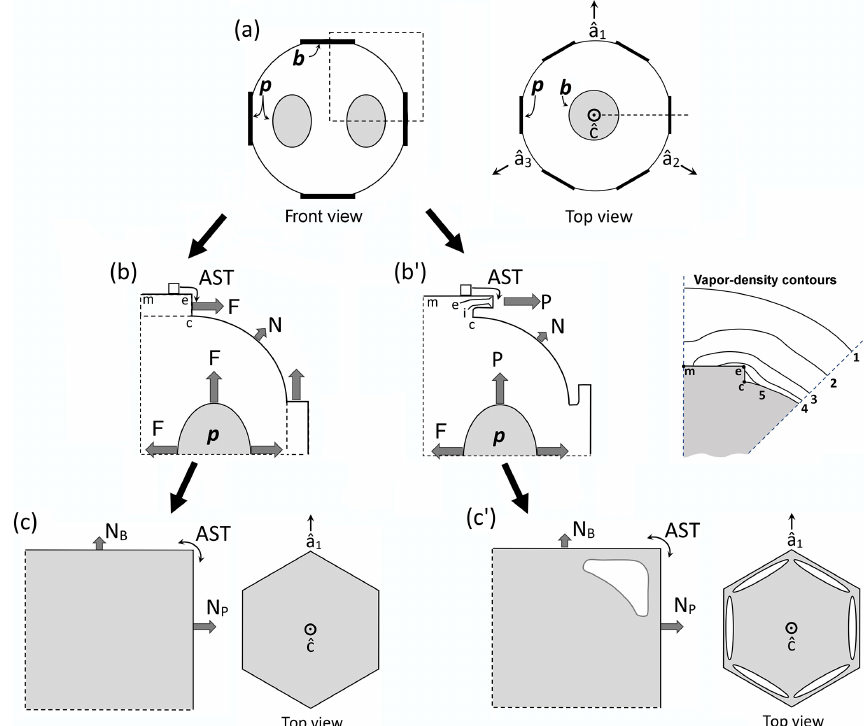
Figure 2. Concepts of lateral facet growth (types F , P , S ) for the droxtal-to-prism transition, driven by AST. (a) Droxtal with small basal b and prism p faces. Front view on the left shows four prism and both basal faces. The top view on the right shows all six prisms and the crystallographic directions of the c axis ˆ c and the a axes ˆ a . (b) Upper-right quadrant of (a) in dashed box, front view. Facet spreading F on top basal and two prism faces largely driven by adjoining surface transport (AST). Normal growth N occurs on rough regions between faces (continuous growth); m is the middle of the facet. (c) Filled-out basal and prism faces. AST continues, likely with net amount to faster- growing face. Top view shows crystallographic directions. (b’) Like (b) , except having protruding growth P between basal and prism faces; e–i is the new lateral-growth front. (c’) Like (c) , except with air enclosure. After (c) and (c’) , standard lateral growth ( S type) occurs due to normal growth of adjoining faces on a fully facetted crystal. Middle row, right, shows qualitative features of five representative vapor-density contours near the lateral-growth front in (b)